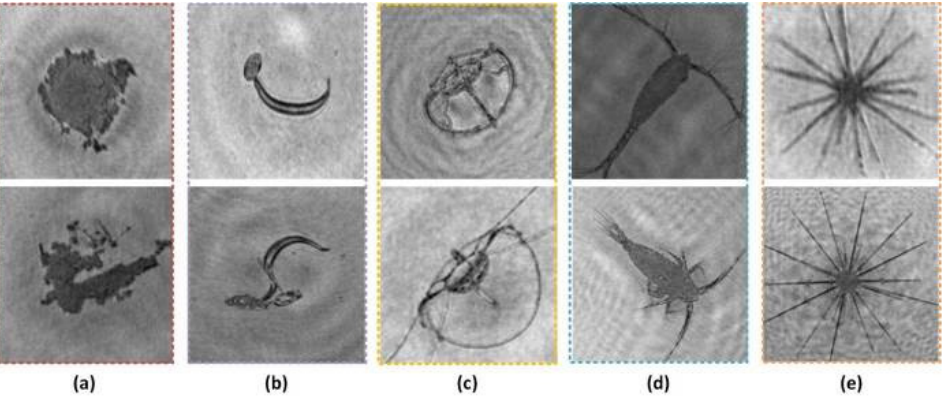
Figure 10. Samples of plankton images in the training set: ( a ) Marina Snow , ( b ) Oikopleura , ( c ) Medusa , ( d ) Copepoda , and ( e ) Acantharian species. ( d ) Copepoda , and ( e ) Acantharian